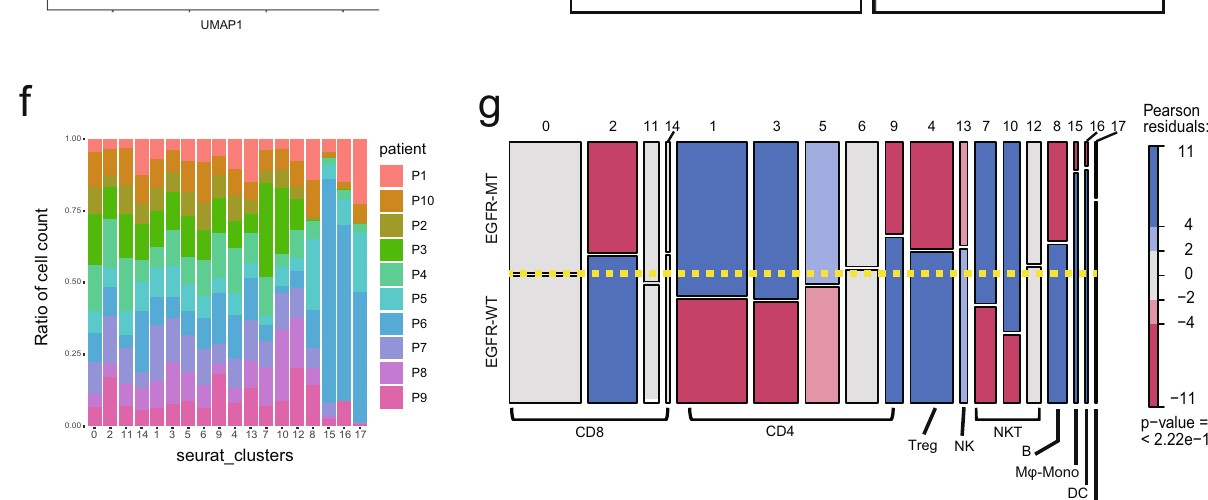
11Pearson residuals: −2 −4 −11 p−value = < 2.22e−16 0.00 individual subsets for each major cell type (e.g., CD8 + T, CD4 + T, Treg, NK, NKT, and B cells), we identi fi ed differentially expressed genes (DEGs) of a subset compared to all other subsets for the same major cell type (subset-DEG) and DEGs between